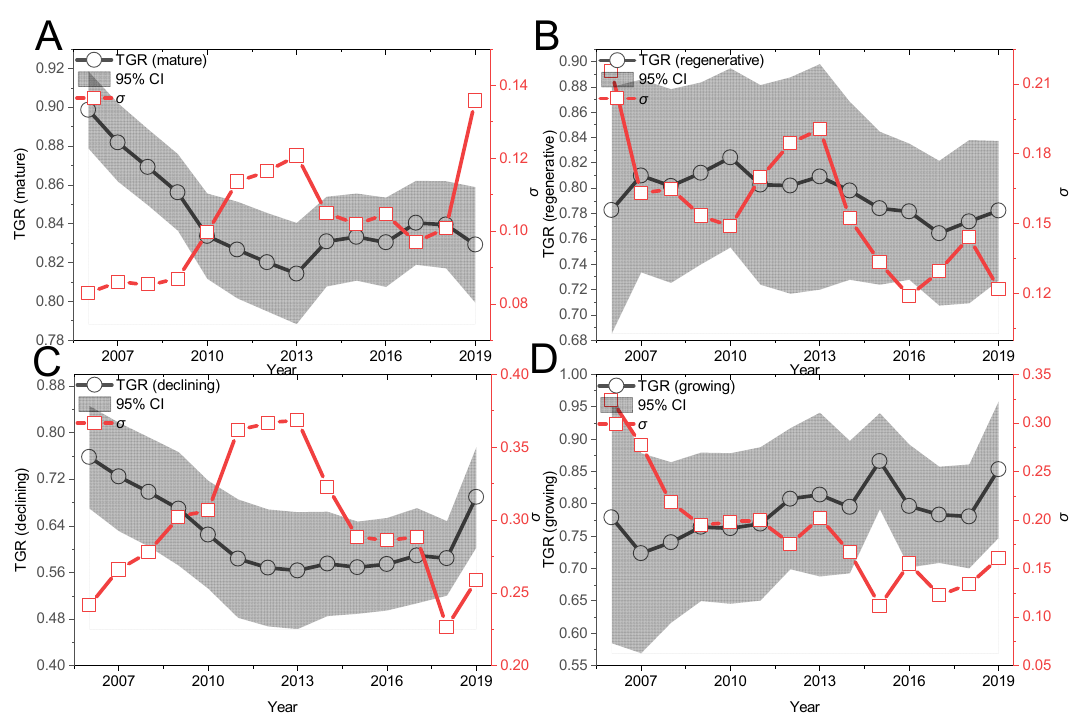
Figure 4. The trend of TGR of four types of mining cities from 2006 to 2019. Note: ( A – D ) represent mature, renewable, declining and growing mining cities respectively. The shaded area represents the 95% confidence interval (CI). σ Represents the convergence trend of MTE annual mean [22].